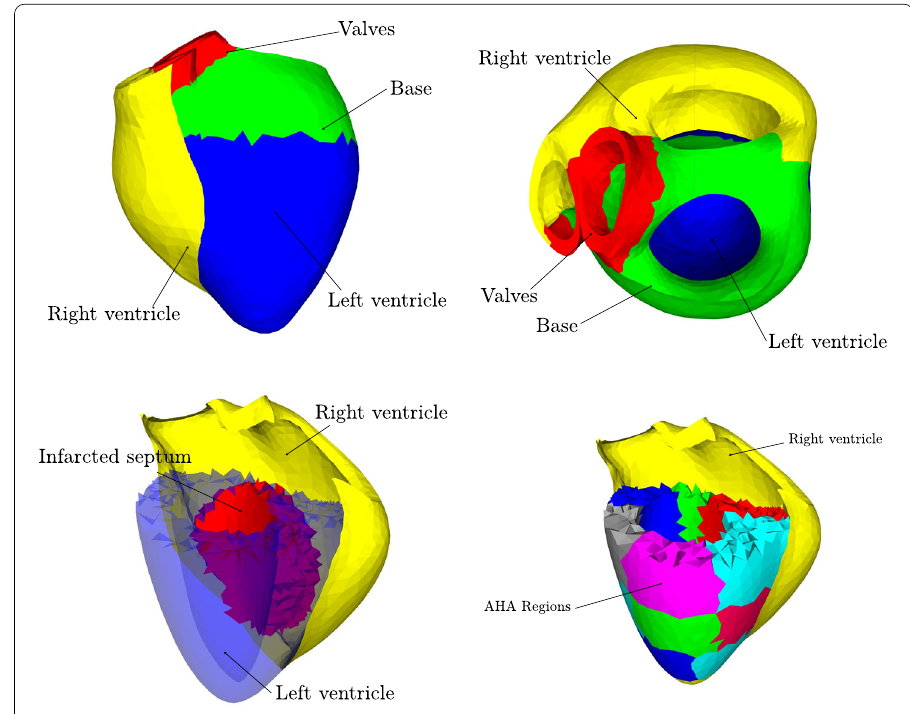
Fig. 6 Model geometry (top row), location of the infarct used in direct simulations and 2-region estimation (bottom-left), and geometry with AHA-regions in the left ventricle (bottom-right) Table 1 Set parameters for the biomechanical heart model (SI units) Valve Base Left Vent. Right Vent C 0 85 . 5 · 10 3 28 . 5 · 10